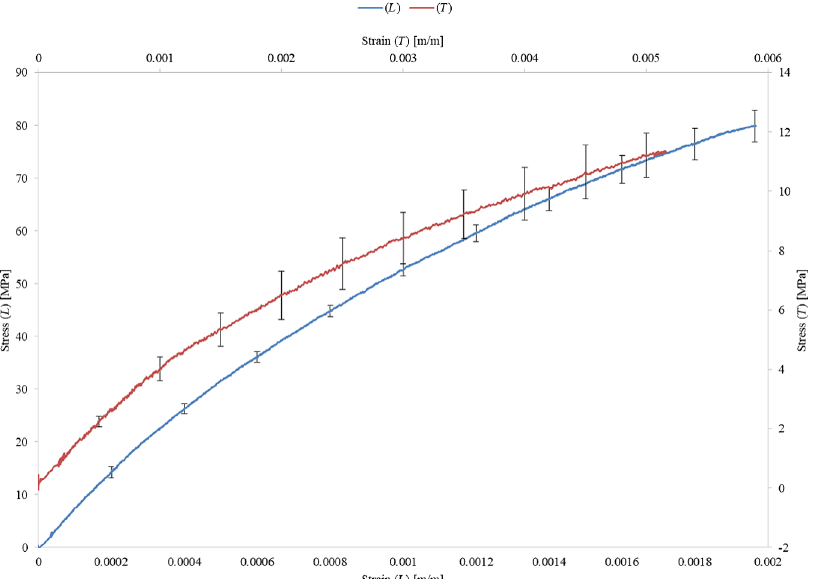
FIG. 16. Plot of flexural stress against strain for MoGr. Longitudinal data and relevant axes marked with ( L ). Transverse data and relevant axes marked with ( T